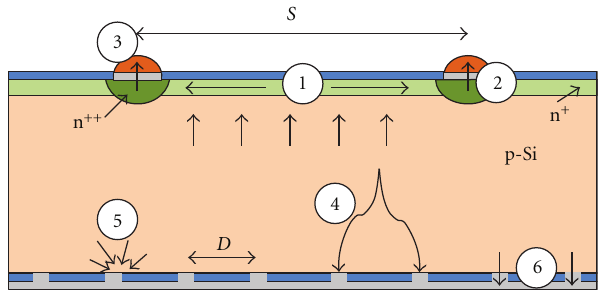
Figure 6: Locations of series resistance contributors in a PERC solar cell. S denotes the spacing between the front fingers, and D the spacing between the rear contact points. The length of the fingers is denoted by L (after